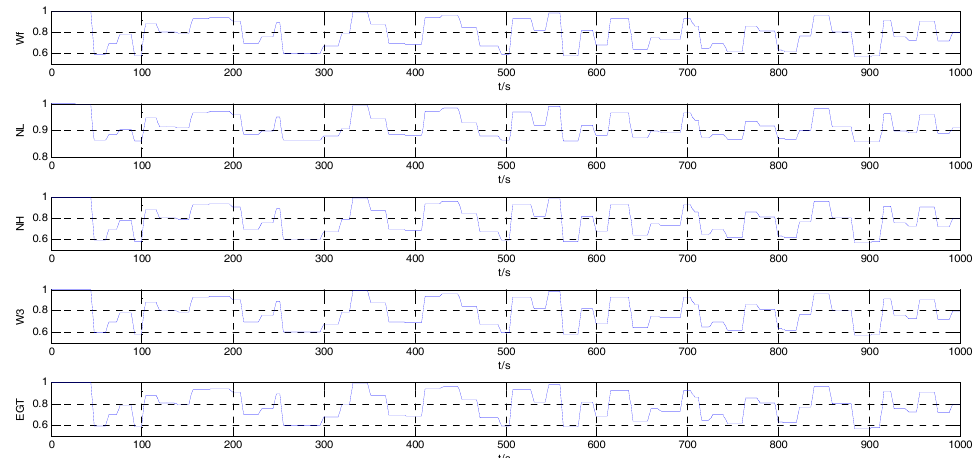
Figure 4. The input and output data from TEM for aircraft engine identification.